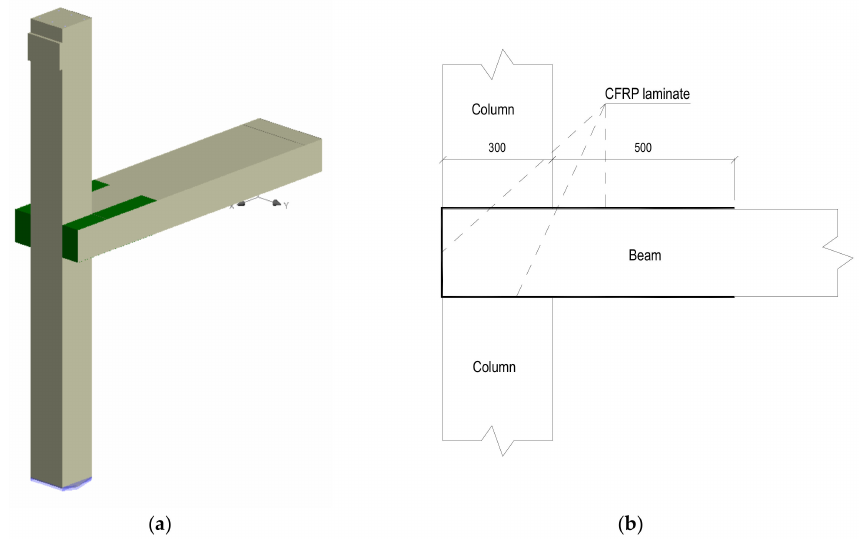
Figure 2. ( a ) 3D view of the CFRP-based U-shaped intervention and ( b ) side view (dimensions in